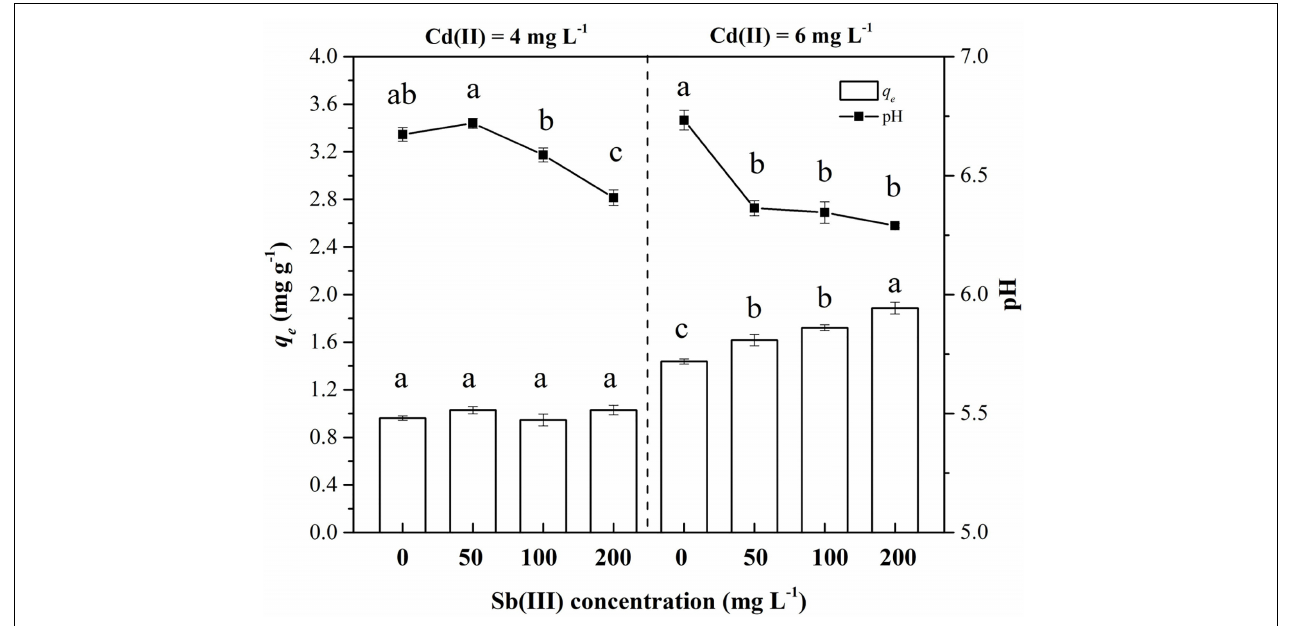
FIGURE 4 | Biosorption of Cd(II) and Sb(III) onto XK8. Letters indicate results of one-way ANOVA. If the letters are completely different, the difference is significant ( p < 0.05), otherwise the difference is not significant ( p > 0.05).